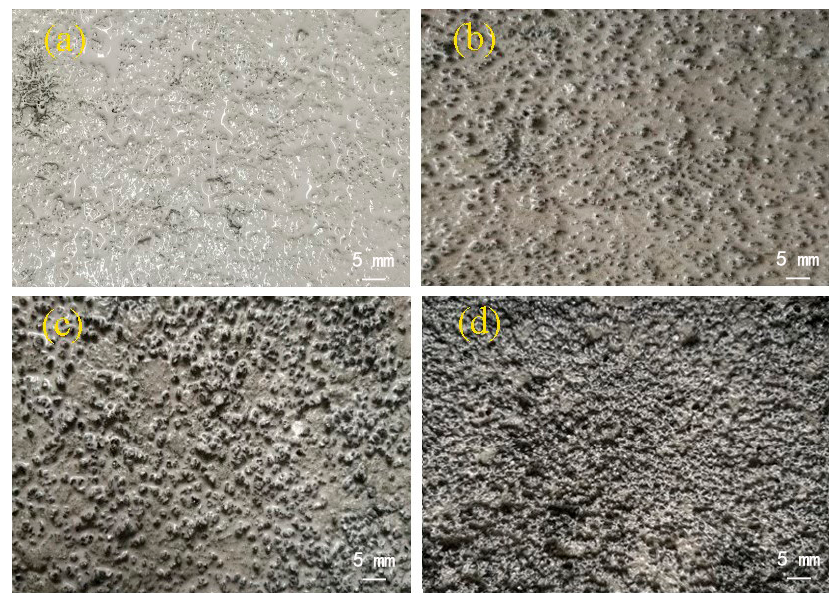
Figure 13. Surface appearance of CCCLs with differing amounts of silicon carbide particles: ( a ) 0 kg/m 2 ; ( b ) 0.5 kg/m 2 ; ( c ) 1 kg/m 2 ; ( d ) 1.5 kg/m 2 .